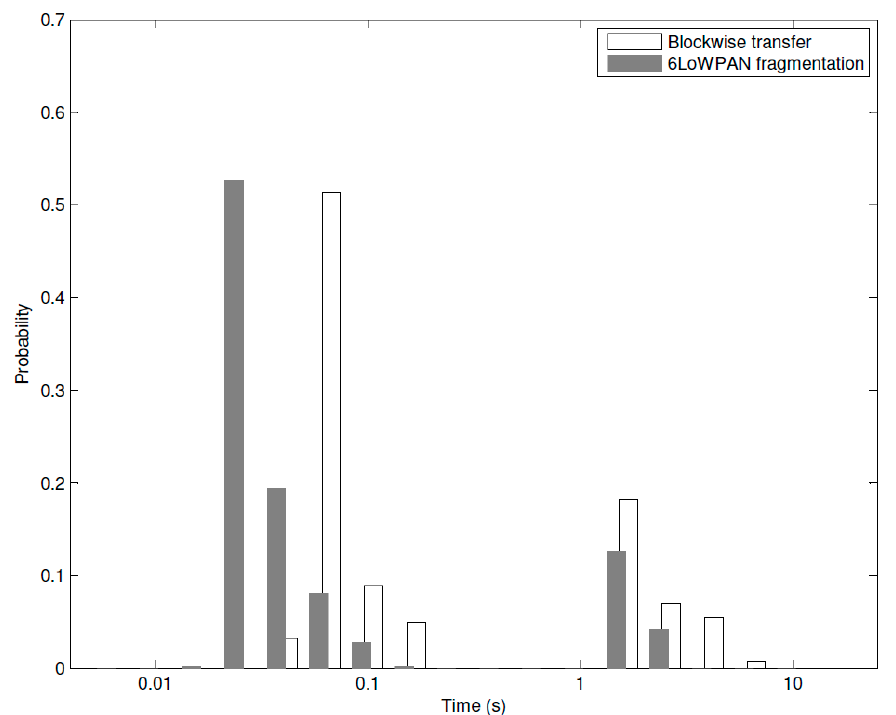
Figure 21. PDF of the latency for a star topology network with 15 nodes and a traffic rate of 1 pkt/s. 6LoWPAN. Each update is composed by five fragments or blocks. For the sake of clarity, the x -axis is shown in logarithmic